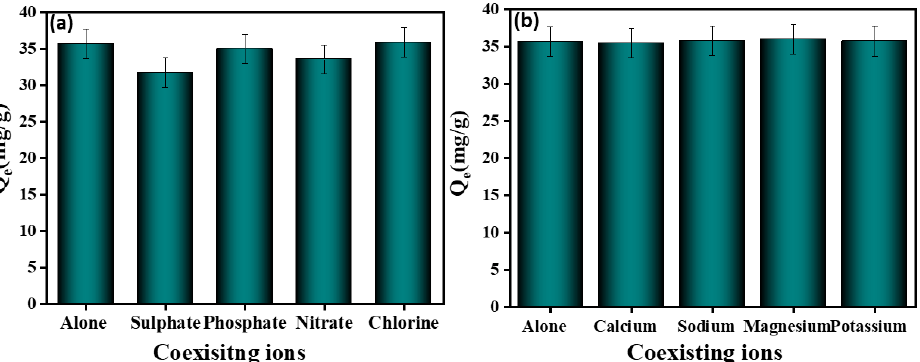
Figure 6. Effects coexisting ions ( a ) anions and ( b ) cations on the Cr(VI) removal from water